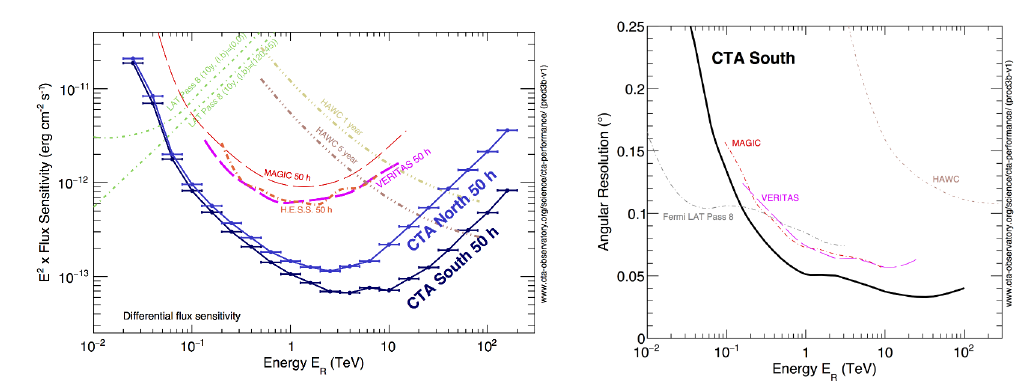
Figure 1. Left: Di ↵ erential gamma-ray flux sensitivity (multiplied by E 2 ) for CTA-South and CTA-North as a function of energy. Also shown are curves for the existing IACTs (H.E.S.S., MAGIC and VERITAS), the air-shower experiment HAWC, and the Fermi-LAT space telescope. Right: Gamma-ray angular resolution for CTA-South as a function of energy, compared to existing instruments. For details on the sensitivity and angular resolution calculations and comparisons, see